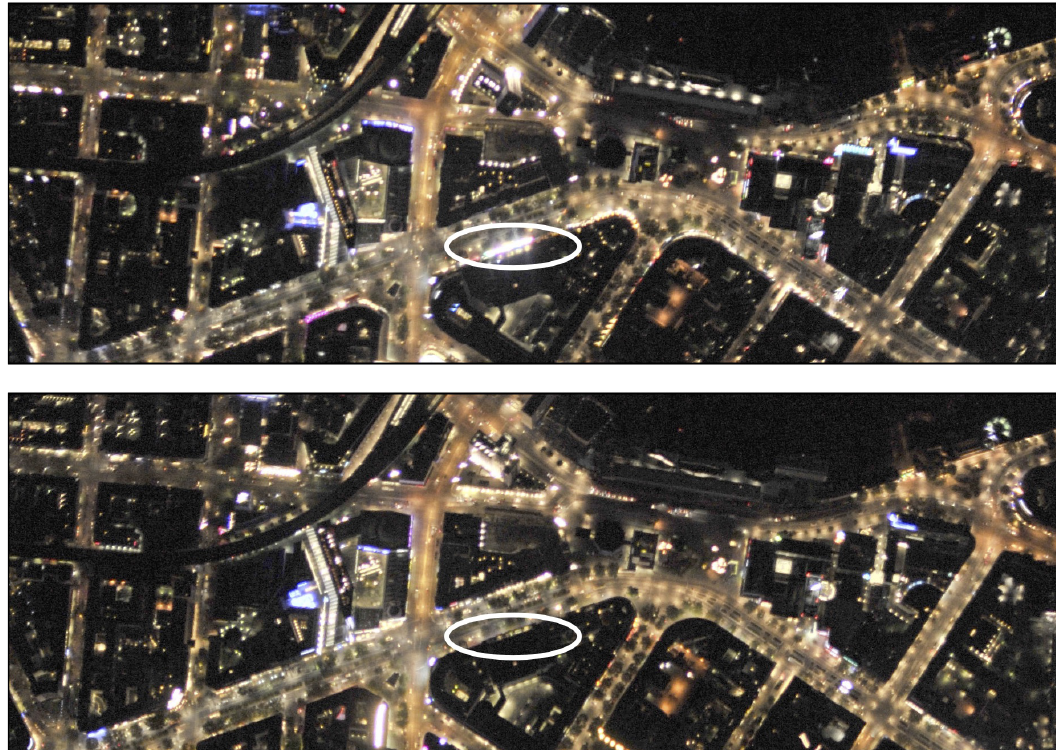
Figure 1. Visibility of facades depends on perspective. The top image is a crop of an photograph taken from the North, so North facing facades such as that highlighted in the oval are visible. The bottom image was taken from the South, so the North facing sides of buildings therefore appear